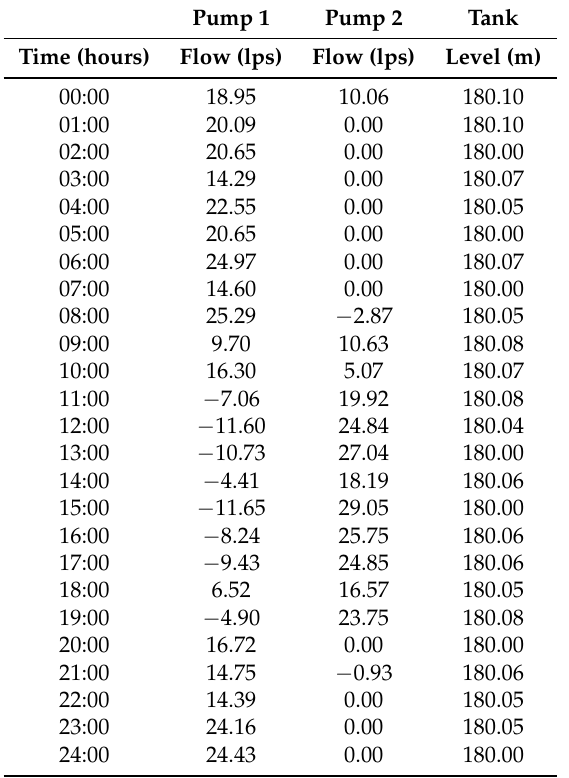
Algorithm 1: Sending data from sensors Result: Sending data from sensors